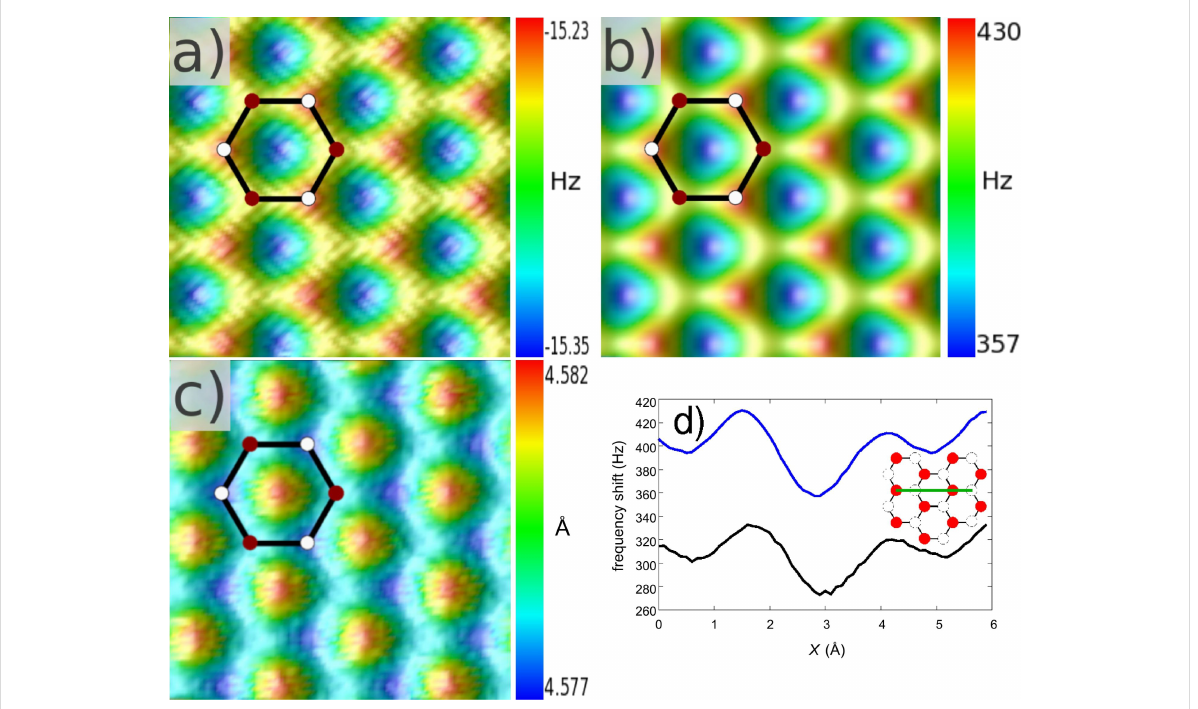
Figure 2: (a) Constant-height FM-AFM image of the graphite surface with H set = 4.3 Å. White and dark circles correspond to A and B atoms, respect- ively. (b) Same as in (a) with H set = 2.75 Å. (c) Constant-frequency-shift FM-AFM image of the graphite surface with Δ f set = − 13 Hz. The size of these three images is 9 × 9 Å 2 . (d) Scanlines above the green line shown in inset in the constant-height mode ( H set = 2.75 Å) for the frozen-atoms (blue) and free-atoms (black)